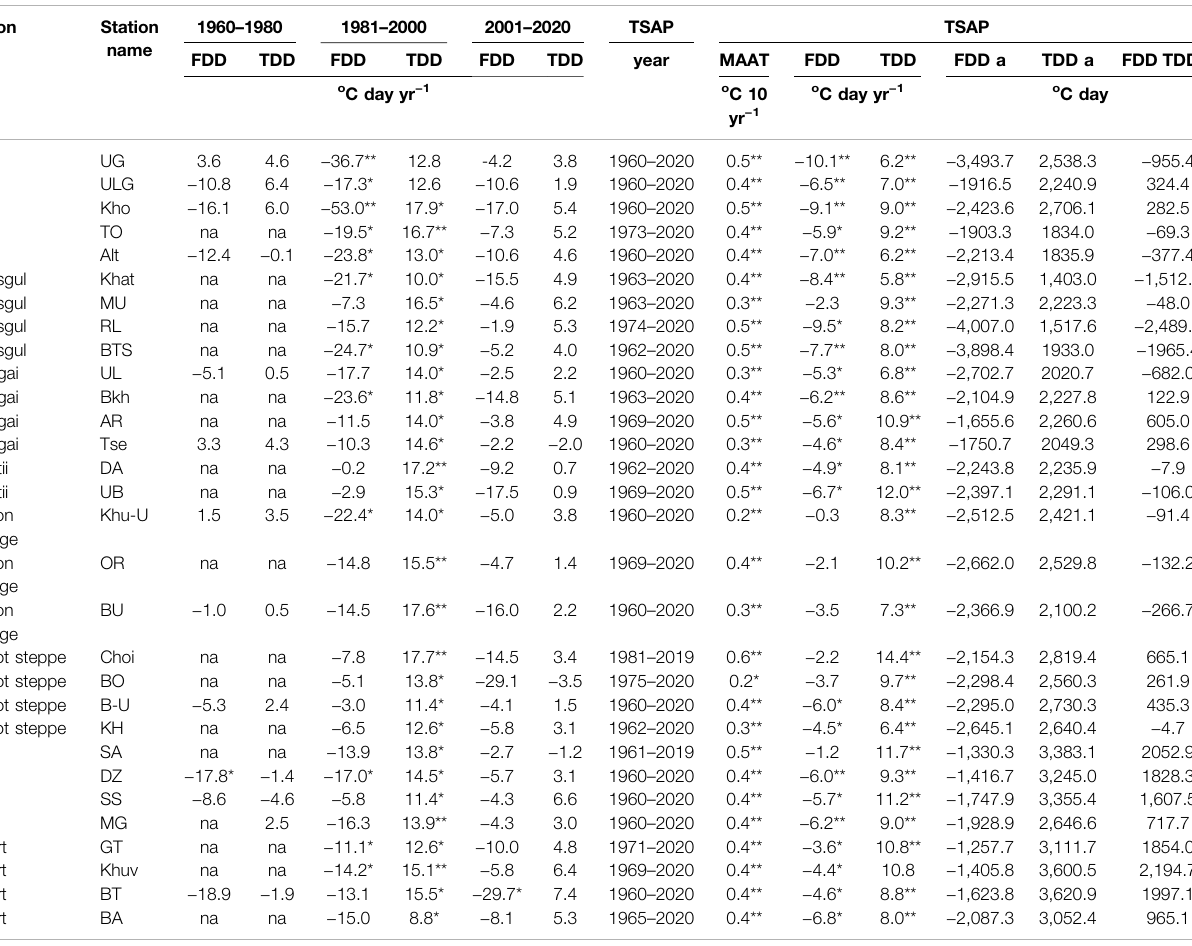
TABLE 1 | Trends in freezing and thawing indices at the 30 meteorological stations during the different periods. TSAP: time series available period; na: non-available data. FDD a and TDD a are the average of freezing degree day and thawing degree day during the TSAP, MAAT is mean annual air temperature, while DFF TDD d is the difference between freezing degree day and thawing degree day. The symbols */** indicate in that p < 0.05 is referred as statistically signi fi cant and p < 0.001 as statistically highly signi fi cant, respectively. Region